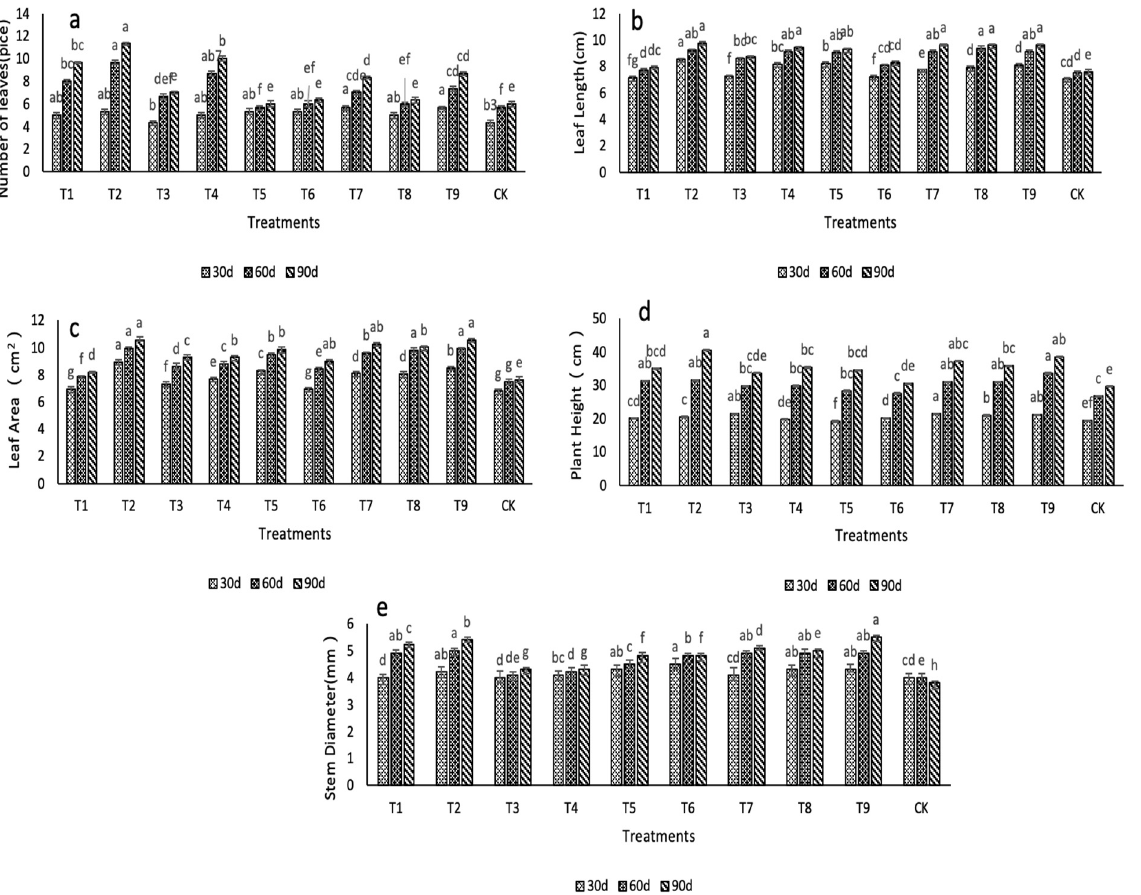
Figure 1. Effects of nitrogen, phosphorus, and potassium on the morphological characteristics of D. denneanum . ( a ) Number of leaves. ( b ) Leaf length. ( c ) Leaf area. ( d ) Plant height. ( e ) Stem diameter. Data are means ± SE ( n = 5) in the figure. Different letters indicate significant differences among the treatments ( p < 0.05).